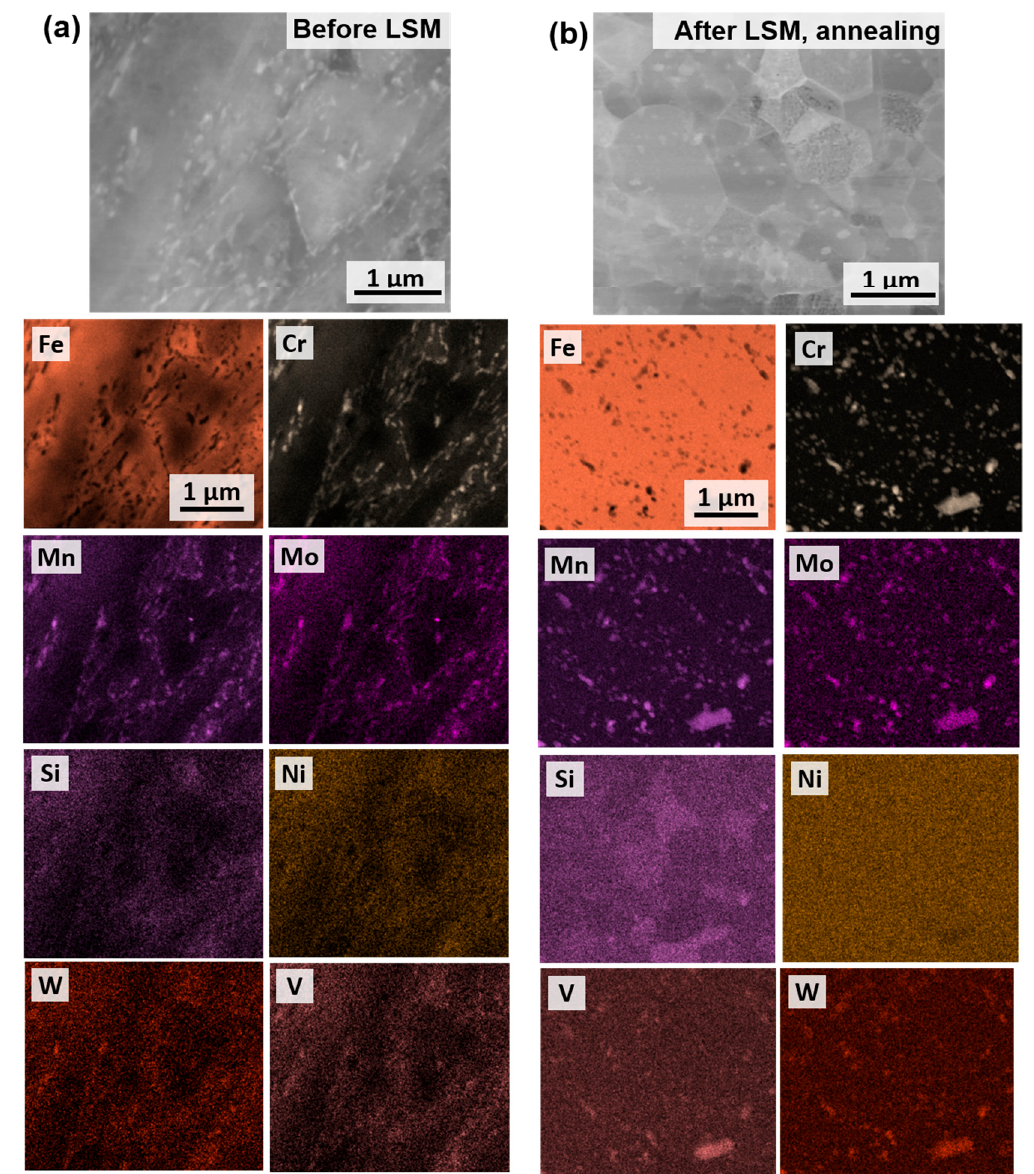
Figure 5. EDX for sample B ( a ) before LSM and ( b ) after LSM and